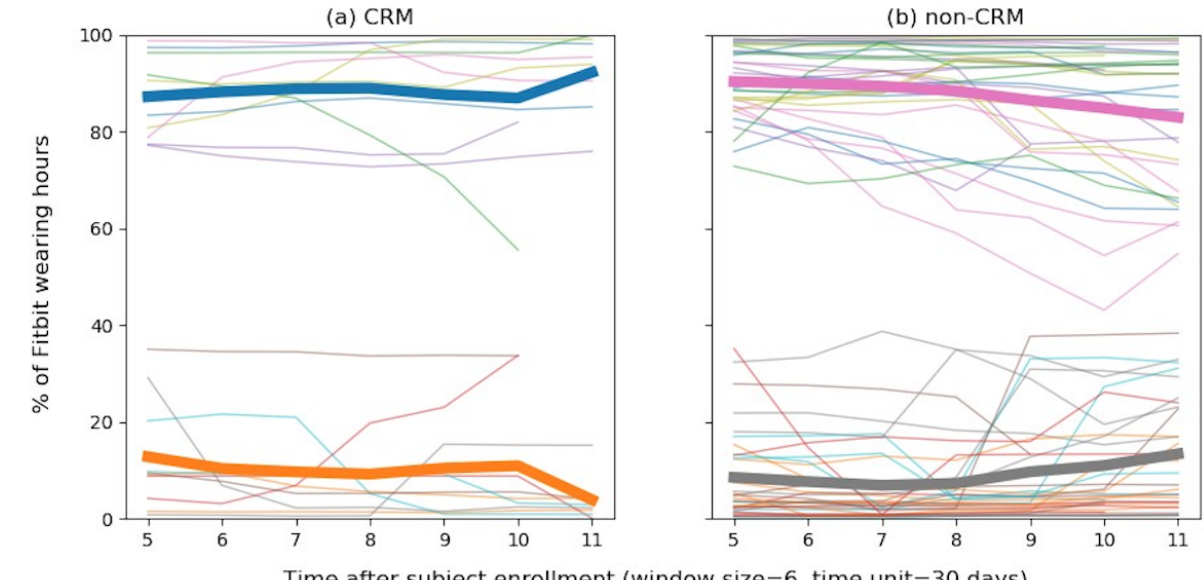
Figure 2. Changes in the Fitbit wearing rate in the CRM and non-CRM groups. A moving average technique was used to report the trend lines by abbreviating the raw time series data (window size=6 days). The time unit on the horizontal axis is 30 days, which means that the number of total wearing hours for 30 days was measured and plotted at each time point. The thin solid lines on the top area are individual trend lines of the change in the Fitbit wearing rate of each patient, and the thick solid line is an average trend line of the individual lines. The lines in the bottom area are the standard deviation trend line (MSD) of the change in the wearing rate. Increasing moving average and decreasing MSD might be